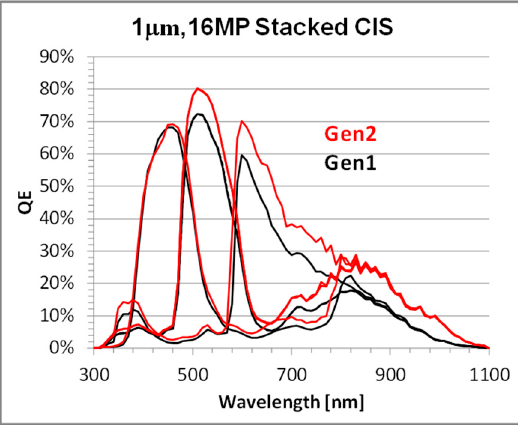
Figure 4. QE comparing Gen1 and Gen2 1 µm, 16 MP technologies.